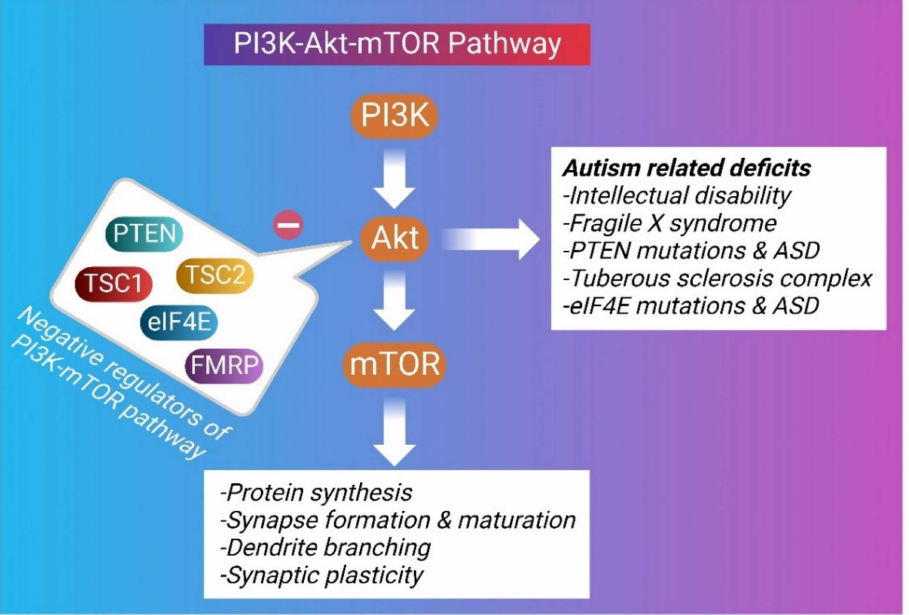
Figure 2. A graphical depiction of the inter-relationship of the PI3K-mTOR system and autism- related